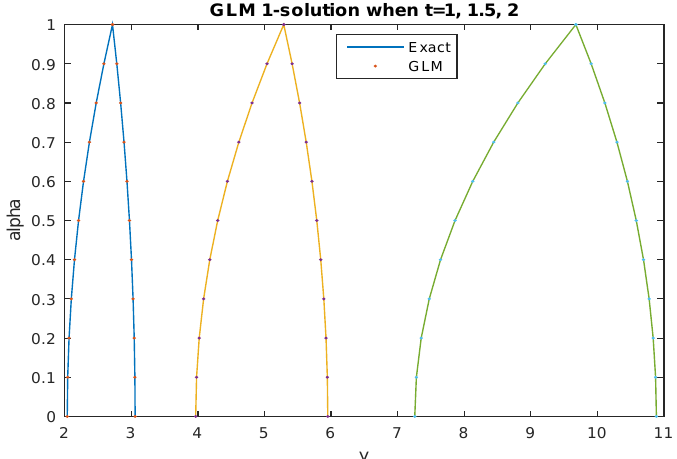
Figure 10. Exact(line) and GLM 1-solutions(stars) for Example 2 when t = 1.0, 1.5 and 2.0 with triangular shaped fuzzy numbers as the initial